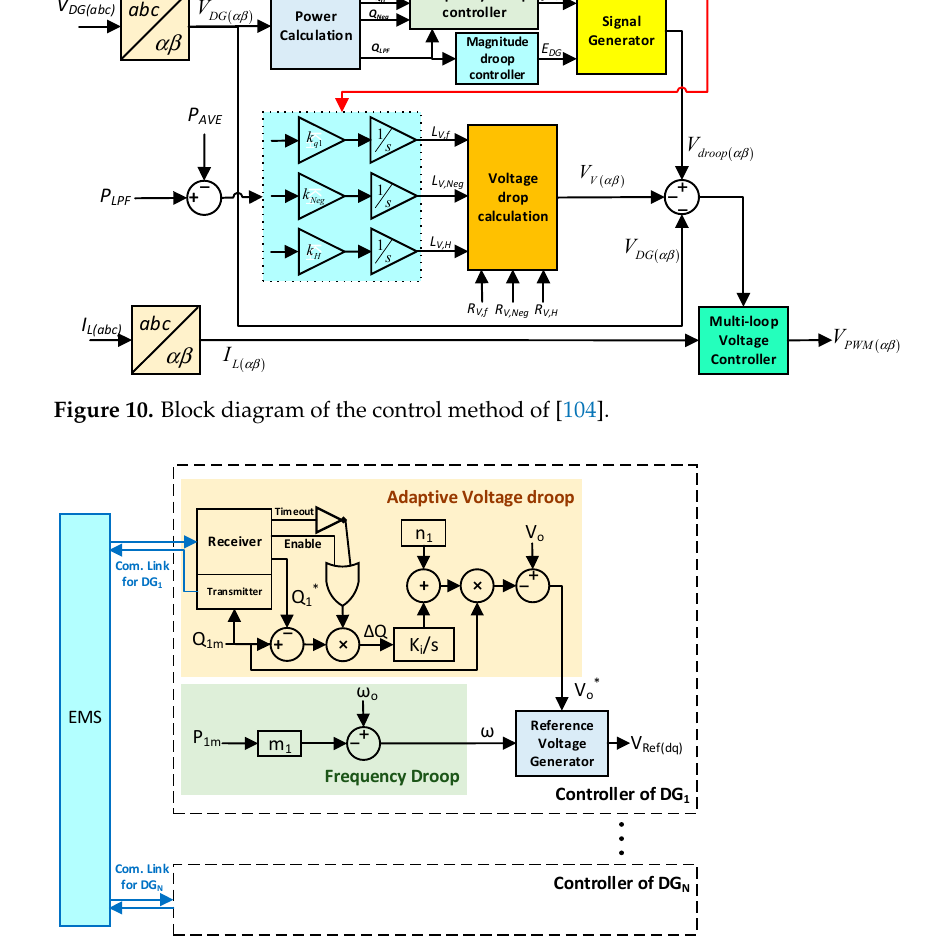
− + Figure 12. Block diagram of the control method introduced in [108]. Generally, ESSs are employed for absorbing the energy mismatches between the gen- eration and the demand sides. Unlike previous works concentrating on energy manage- ment through communication systems, Oureilidis KO et al. introduced a WL control methodology for maintaining the frequency and voltage of an ACMG within permissible limits by employing an ESS [109]. Besides computing ESS capacity, proper reactive and active power sharing is achieved among parallel DERs by a droop controller. In [110], the design, establishment, and requirements of the CAN protocol (with a speed up to 1 Mbps; robust against severe test conditions) as the communication link among high-frequency power converters are studied for controlling and coordinating the converters in a master–slave configuration. In Table 13, the most important LBcom-based primary methods are summarized and categorized.